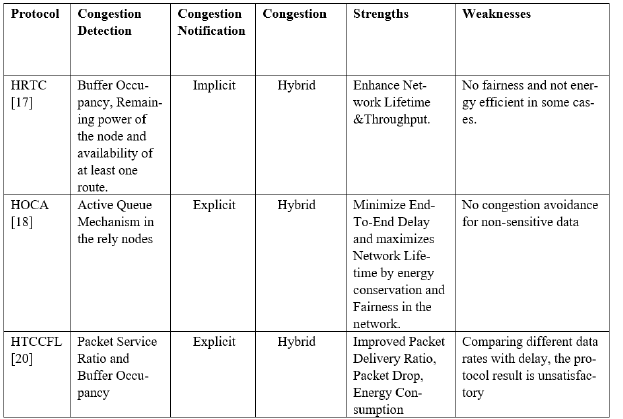
Table 2. Hybrid Congestion Control